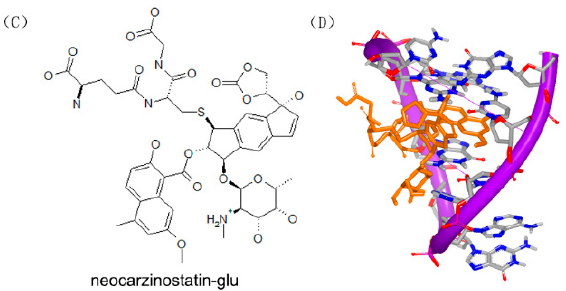
Figure 11. ( A ) Chemical structure of neocarzinostatin-gb; ( B ) complex of a DNA with neocarzinostatin-gb (PDB code: 1KVH); ( C ) chemical structure of neocarzinostatin-glu; and ( D ) complex of DNA with neocarzinostatin-glu (PDB code: 1MP7). The orange structure represents the small molecule; the purple structure represents the backbone of nucleic acid; the blue and red atoms in the molecule represent nitrogen and oxygen atoms,